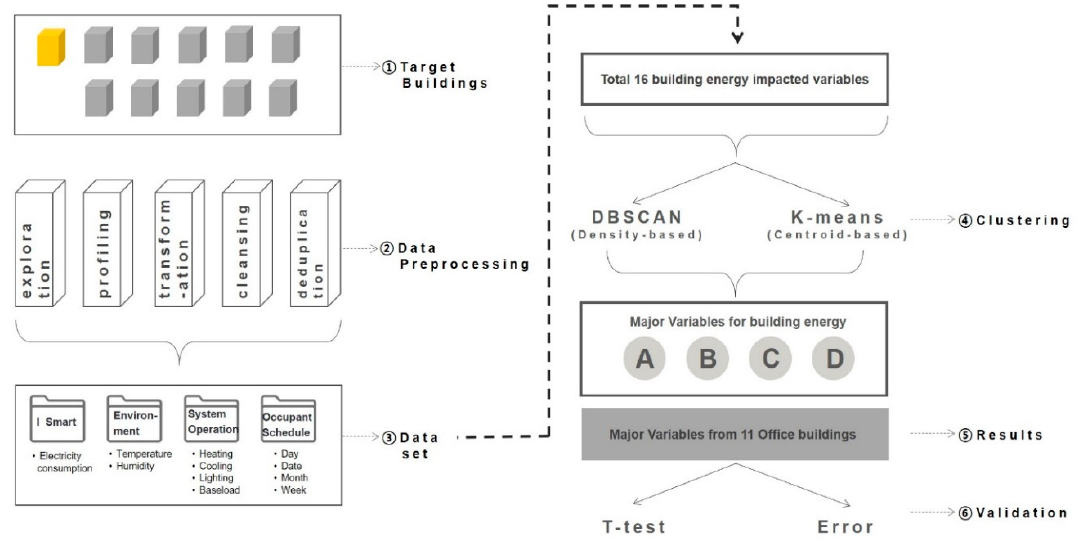
Figure 2. Schematic representation of the research process.